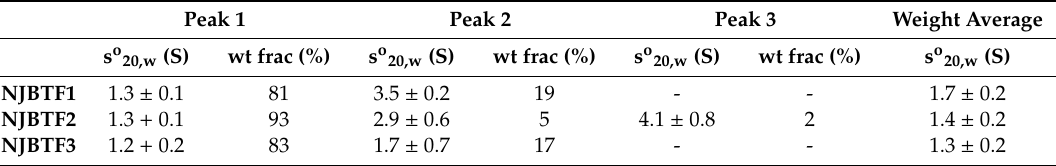
Table 2. Sedimentation coe ffi cients of C. moschata polysaccharide